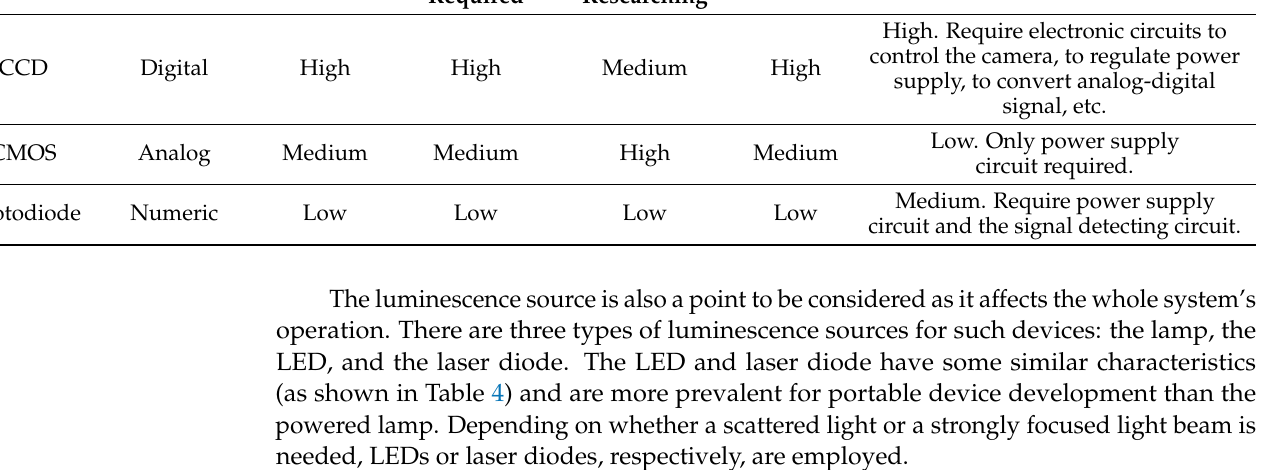
Table 4. Comparison characteristics of an LED, a laser diode and a lamp for the luminescence source of a portable device. Light